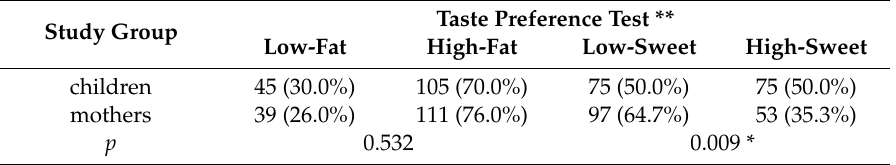
Table 1. Preferences of the fat (character) and sweet taste among children and their